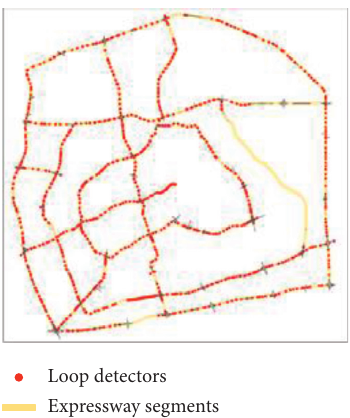
Figure 5: Expressway network of Shanghai